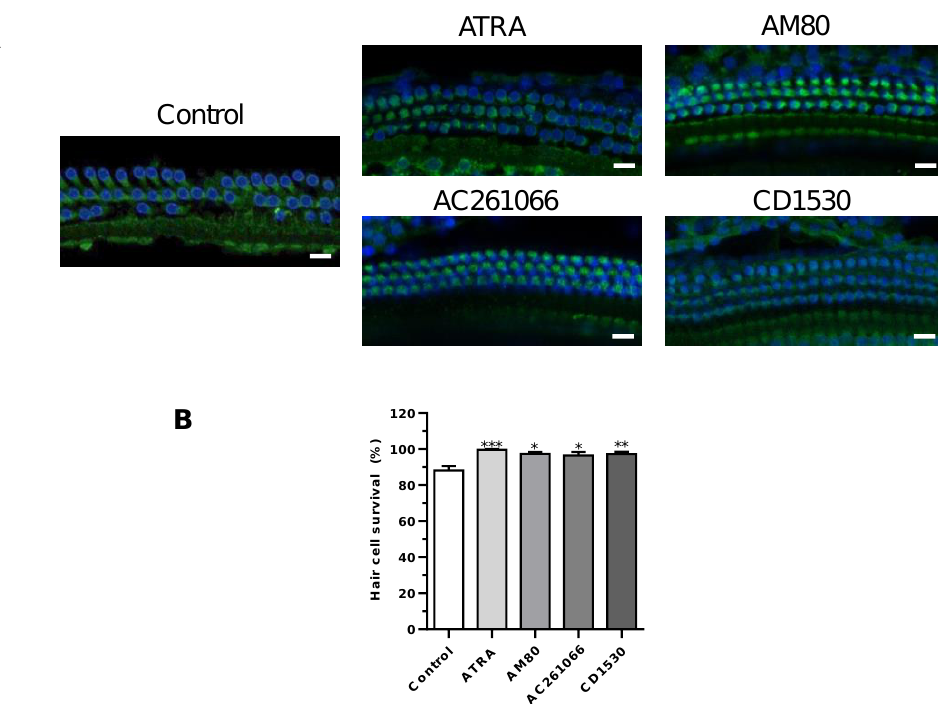
Figure 4. Effect of all-trans retinoic acid (ATRA) on hair cell damage after noise exposure. ( A ) Day 7, whole mount preparation of the cochlea was performed. Hair cells were stained with 4′,6 -diamidino- 2-phenylindole (DAPI; blue) and Myosin 7a (green), and observed under a confocal microscope (scale bar, 20 µ m). Images of middle turn of cochlea, control group showed damaged outer hair cells, whereas the selective retinoic acid receptor (RAR) agonist groups showed preserved outer hair cells. ( B ) Outer hair cell survival rate in each group was compared ( n = 6–10). Scale bars, 10 µ m. Statistical analysis was performed with the reference value of lane 1. *** p < 0.001, ** p < 0.01, * p < 0.05. Table 1. The preventive e ff ects of retinoic acid receptor agonists on noise-induced hearing loss. Compounds Hearing Threshold (dB SPL) Wave I Amplitude (nV) Hair Cell Survival (%) Control 92.1 ± 16.8